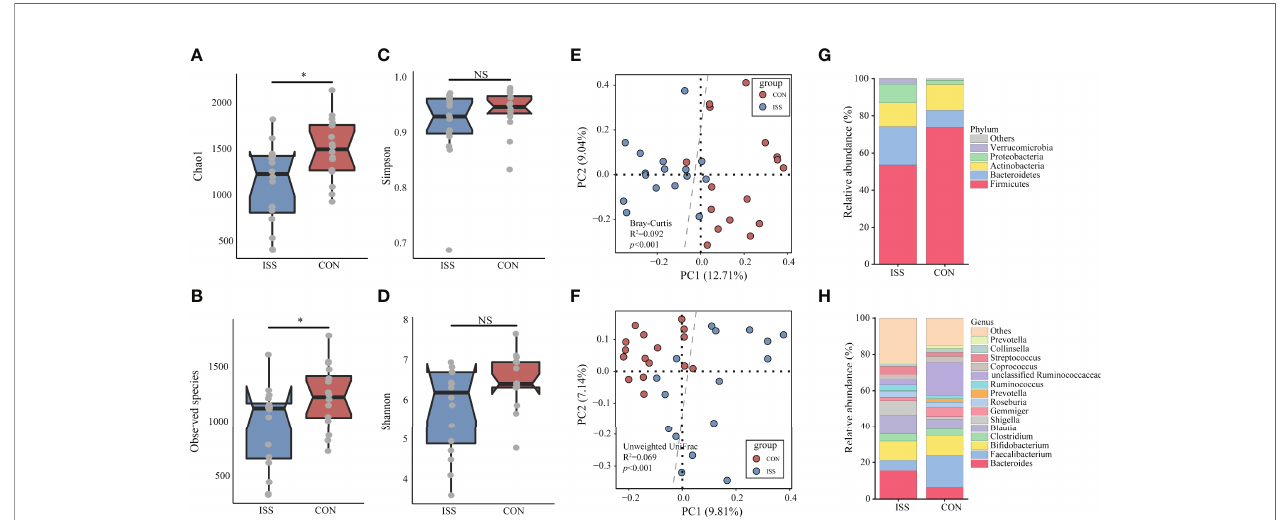
FIGURE 2 | The a -diversity of the microbiota, presented as the Chao1 index (A) , Observed species index (B) , Simpson index (C) , and Shannon index (D) , from ISS patients and healthy subjects was calculated (Chao1 index, P = 0.018; Observed species index, P = 0.038). The gut microbiota composition of ISS patients was signi fi cantly different from that of healthy subjects. The b -diversity of microbiota in the ISS and CON groups was calculated by the Bray-Curtis distance (E) and unweighted UniFrac distance (F) and is shown in the PCoA plot (Adonis test, Bray-Curtis distance, R2 = 0.092, P < 0.001; unweighted UniFrac distance, R2 = 0.069, P < 0.001). Each point represents the composition of the microbiota of one participant. The boxplots display the predominant bacterial taxa at the phylum (G) and genus (H) levels in the ISS and CON groups. *P < 0.05. NS, no signi fi